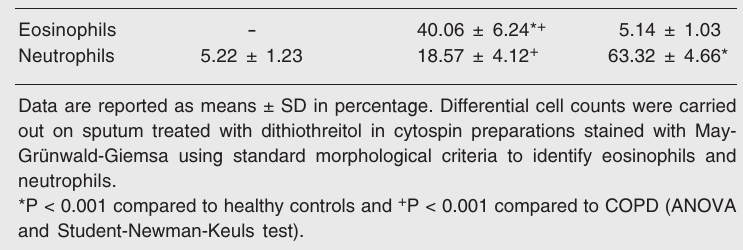
Table 2. Inflammatory cells in sputum of patients with asthma and chronic obstructive pulmonary disease (COPD). Healthy controls (N =